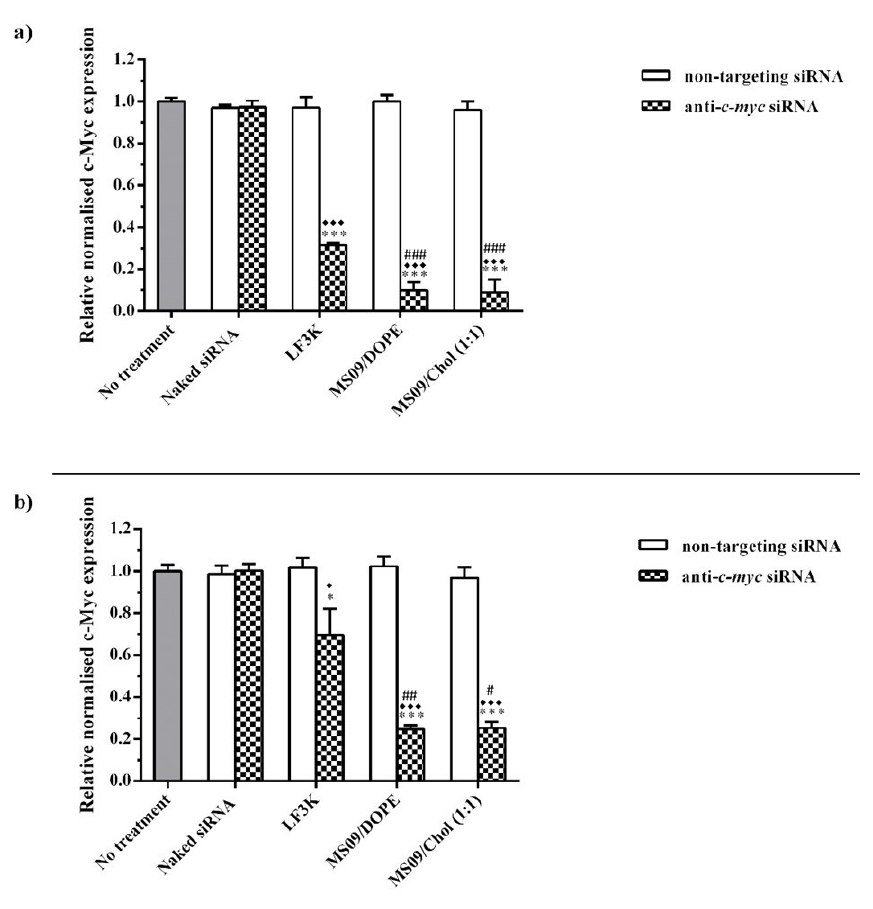
Figure 8. Effect of anti- c-myc lipoplexes on c-myc protein expression in a) MCF-7 and b) HT-29 cells, following transfection with MS09:DOPE and MS09:Chol lipoplexes. c-myc expression was quantified by ELISA, and normalized to the internal control, β -actin. Each column represents the mean ± SD ( n = 3). * P < 0.05, *** P < 0.001 vs . naked siRNA; ♦ P < 0.05, ♦♦♦ P < 0.001 vs . non-targeting siRNA; # P <0.05, ## P < 0.01, ### P < 0.001 vs . anti c-myc LF3K. P > 0.05, with respect to anti c-myc MS09:Chol vs . anti- c-my c MS09:DOPE. LF3K= Lipofectamine ™